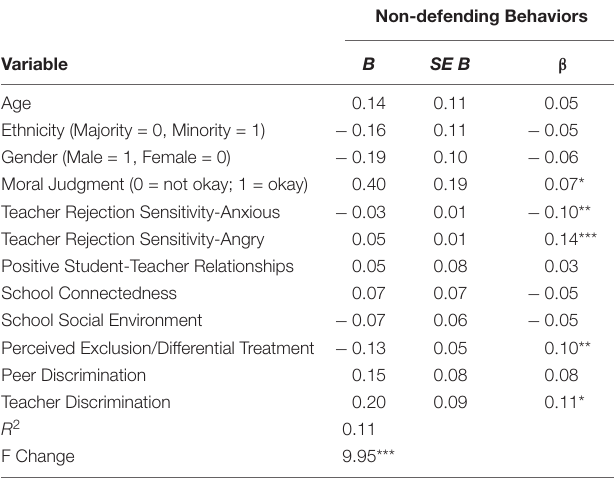
TABLE 4 | Responses to social exclusion: non-defending behaviors.